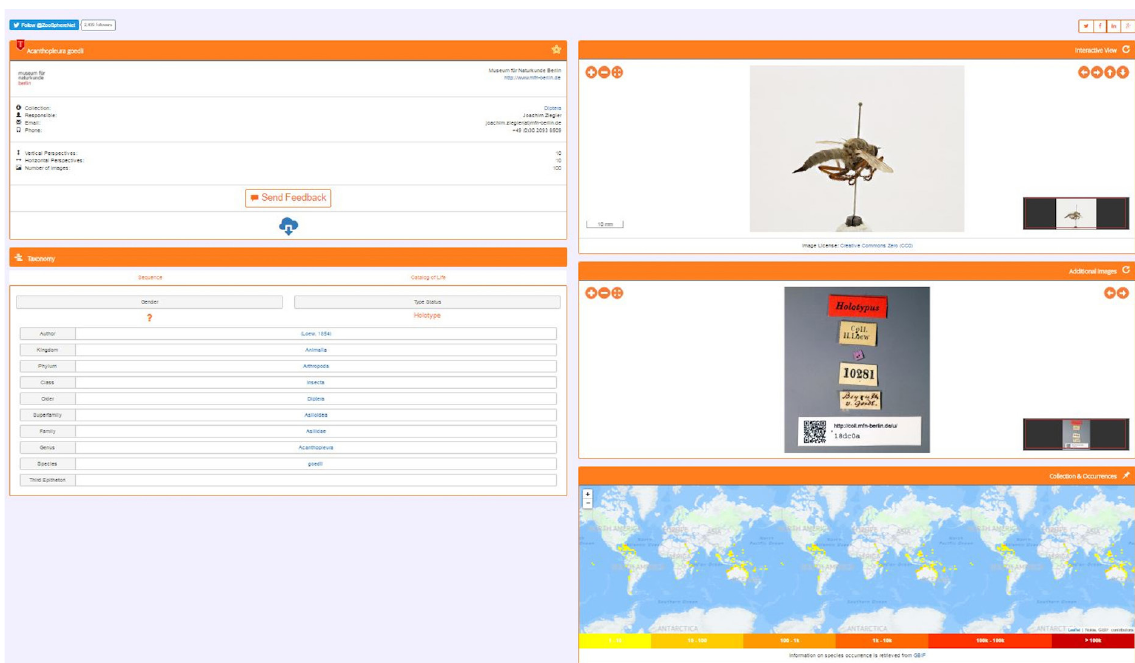
Fig. 2.21. Overview of the specimen page visible at Zoosphere.net. Image copyright MfN.